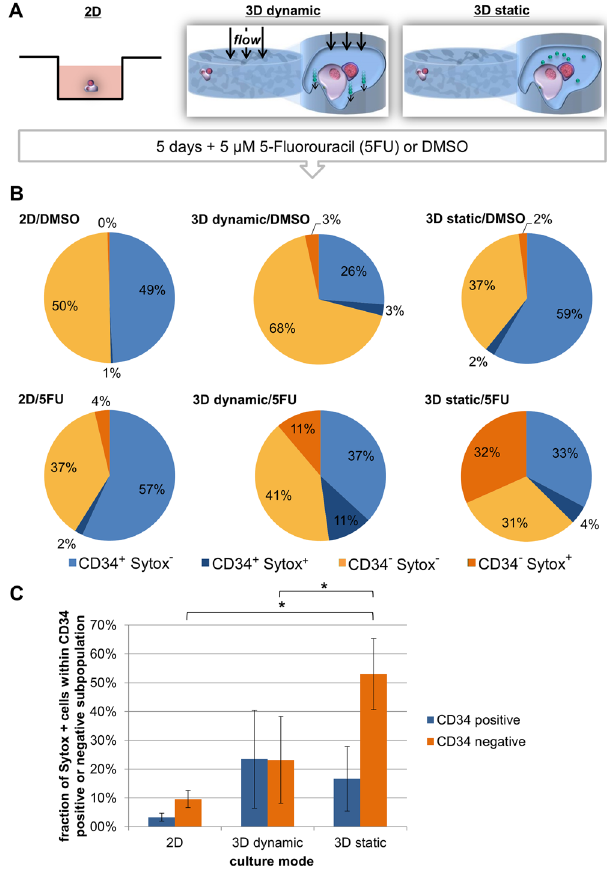
Figure 6. The culture mode affects the sensitivity of HSPCs to the myelotoxic drug 5-fluorouracil. ( A ) Schematic representation of the experiment. HSPCs were cultured together with MSCs in standard 2D tissue culture plates or in macroporous 3D scaffolds under static or dynamic conditions in the presence of 5-fluorouracil (5FU) or DMSO as a control for 5 days. Cells are drawn in violet, the scaffold is represented in blue, secreted molecules in green and fluid flow is indicated by black arrows. ( B ) The response of HSPCs to the 5FU treatment by cell death was assessed by Sytox staining and the results are presented as circle diagrams. Percentage of CD34 + cells is depicted in blue, percentage of CD34 − in orange, live (Sytox − ) cells in light color and dead or late apoptotic cells (Sytox + ) in dark blue or dark orange. ( C ) The percentage of Sytox + cells within the CD34 + (blue) and CD34 − subpopulation (orange) of cells after 5 days in the presence of 5FU under the different culture conditions are presented as bar graph with error bars (mean ± standard deviation). N = 3 independent